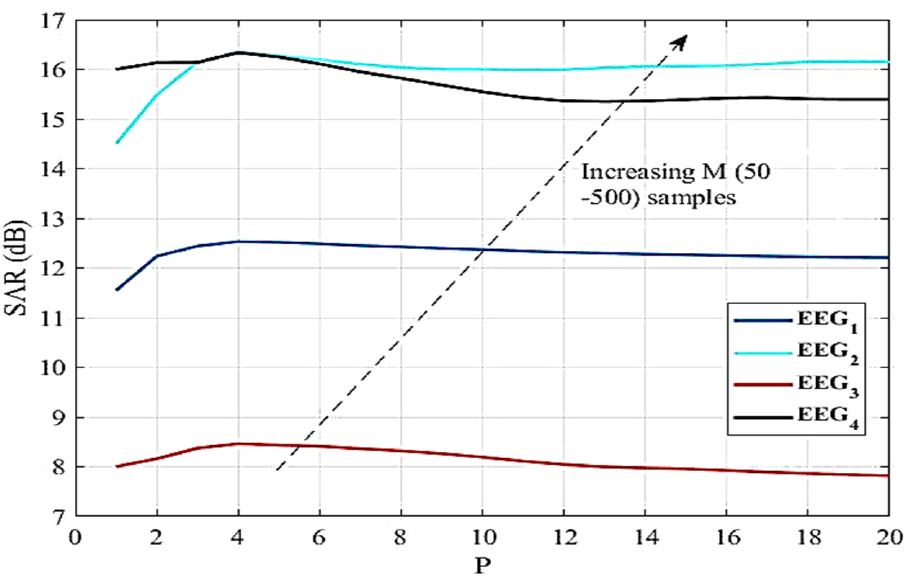
Figure 4. Demonstration of SAR improvement for different values of P at λ = 0.0469. Curves are plotted for different M (50–500). The arrow denotes the increasing values of M. Table 5. Comparison of the computation time for different values of M.